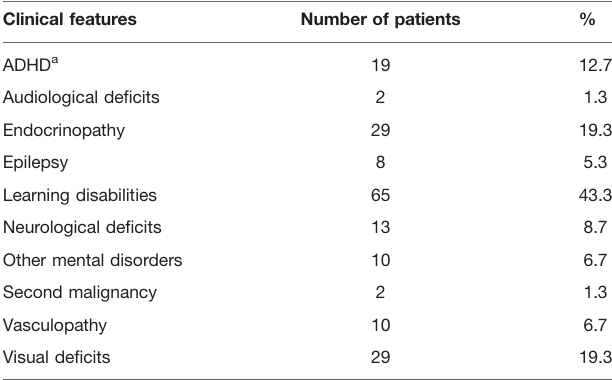
TABLE 4 | Clinical features of children with NF1 and OPG. Clinical features